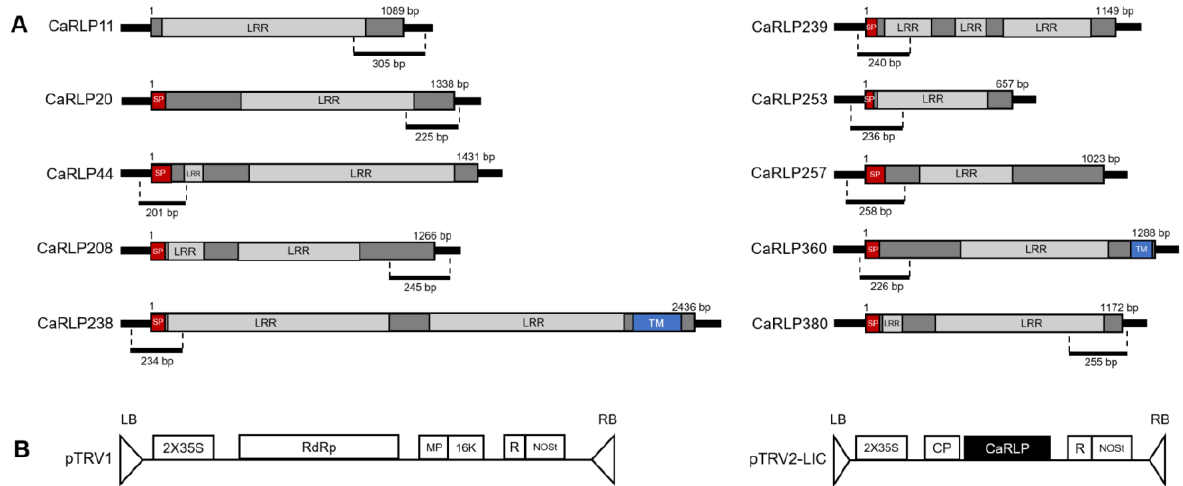
Figure 3. RLP (receptor-like protein) structure and schematic diagram of silenced region of each CaRLP ( Capsicum annuum receptor-like proteins) and TRV ( Tobacco rattle virus )-based VIGS (virus-induced gene silencing) vector. ( A ) RLP structure with the diagram of silencing region of CaRLPs. Partial fragment of the gene used for silencing are shown below full CDS (coding sequence) region of each CaRLP. LRR, leucine rich repeat; SP, signal peptide; TM, transmembrane domain. Dark gray region without domain name in CDS indicates non-LRR region. ( B ) Map of the TRV-based VIGS vector used in this study. Partial fragments of each CaRLP were cloned into black colored region (named “CaRLP”) of pTRV2-LIC. LB, left borders of the T-DNA; RB, right borders of the T-DNA; 2X35S, two copies of the Cauliflower mosaic virus 35S promoter; CP, coat protein; RdRp, RNA-dependent RNA polymerase; MP, movement protein; 16 K, 16 Kda protein; R, self-cleaving ribozyme; NOSt, nos-terminator.